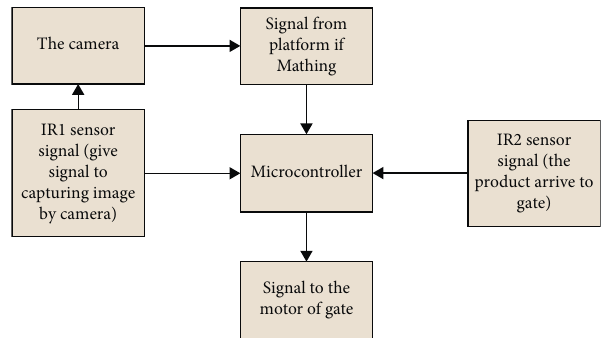
Figure 5: The main elements in the control unit of the sorting system.